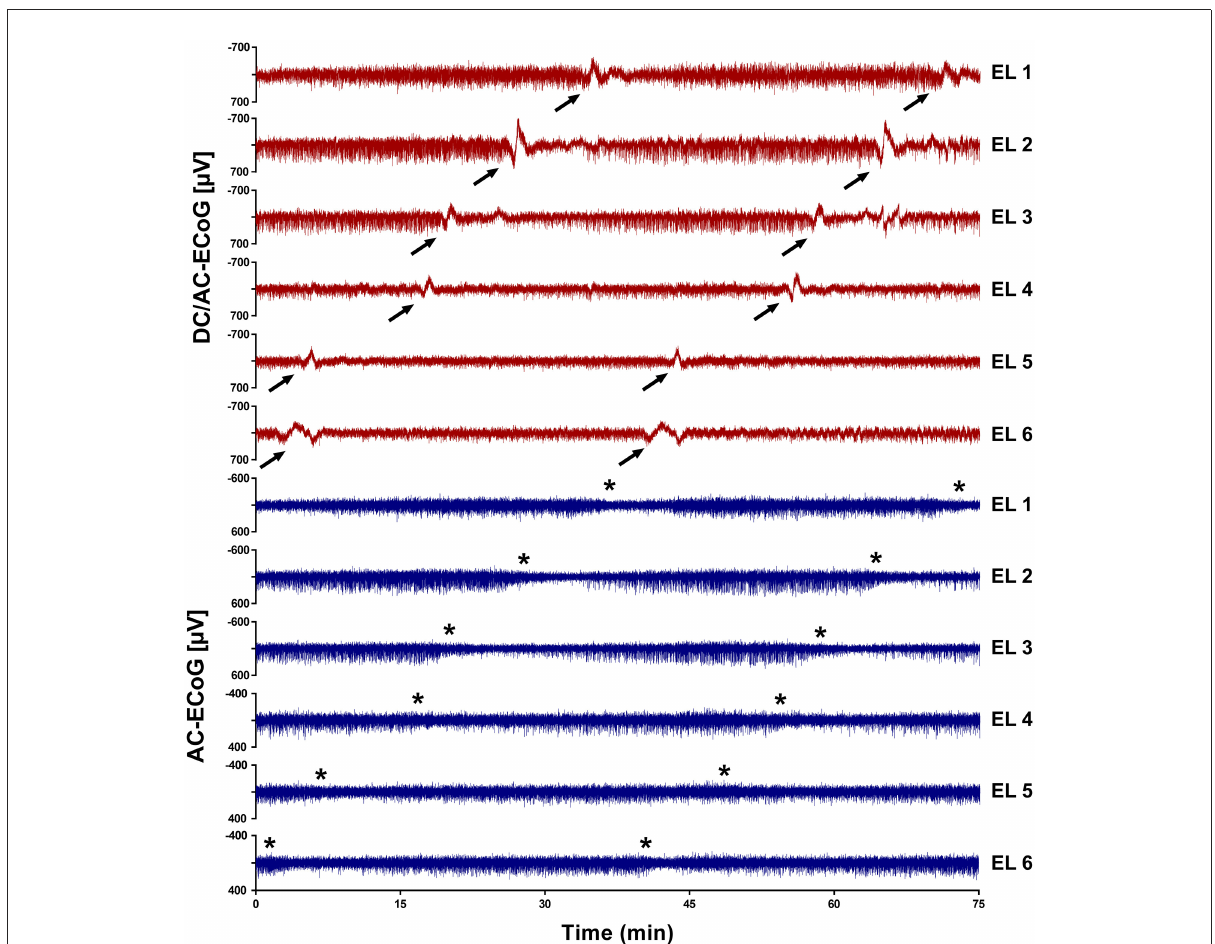
FIGURE3 Subdural ECoG recording traces of Spencer-type electrodes arrays. In this case (patient No. 1), monitoring was performed using a 6-contact Spencer-type electrode array placed through a right frontal burr-hole. The occurrence of clustered SDs can be observed by the large negative shift in the direct current ECoG (DC/AC-ECoG; band-pass: 0.01–45Hz; red traces, arrows). The SDs induced depression of the spontaneous cortical activity in the alternating current range (AC-ECoG; band-pass: 0.5–45Hz, blue traces, asterisks show the beginning of a depression period). EL,